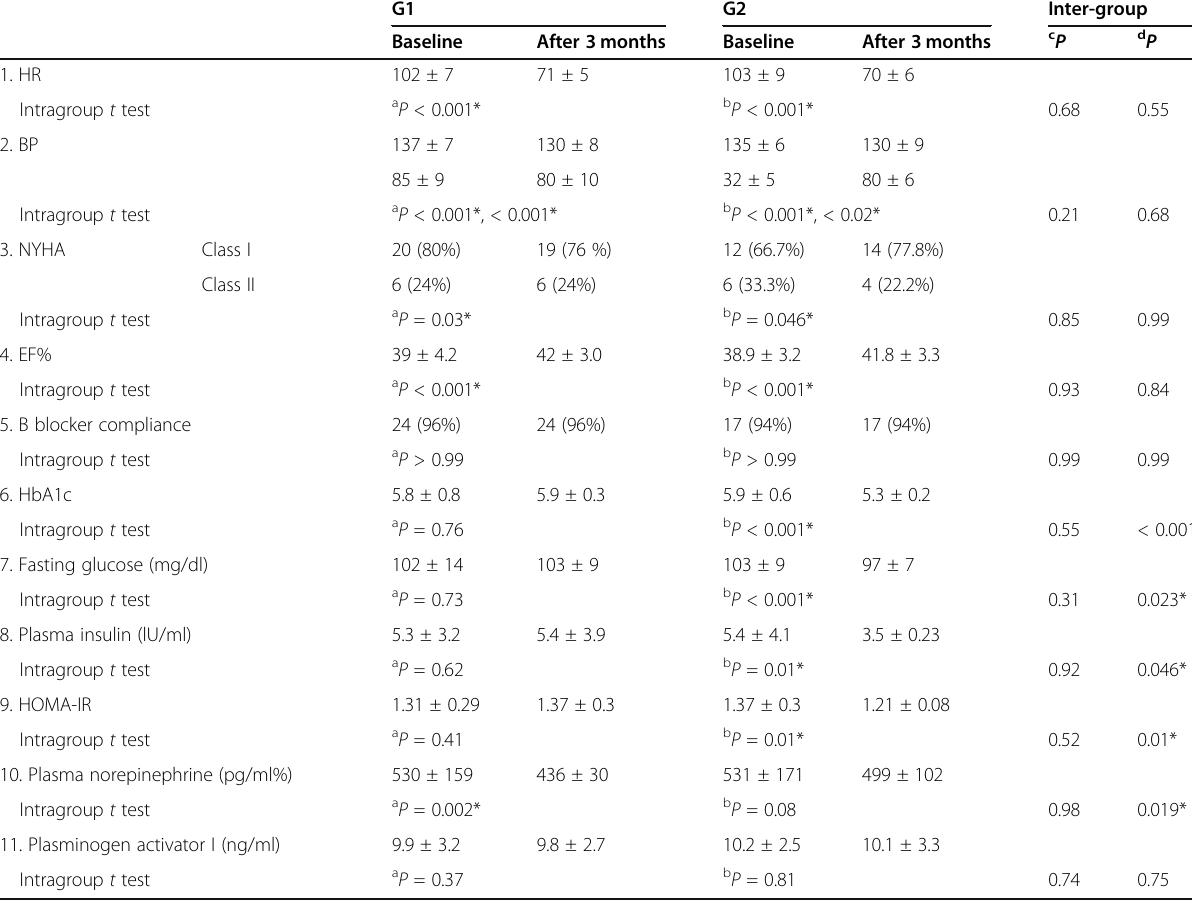
Table 2 Intra- versus intergroup comparison of variables at the baseline versus at 3 months follow-up among the two groups G1 G2 Inter-group Baseline After 3 months Baseline After 3 months